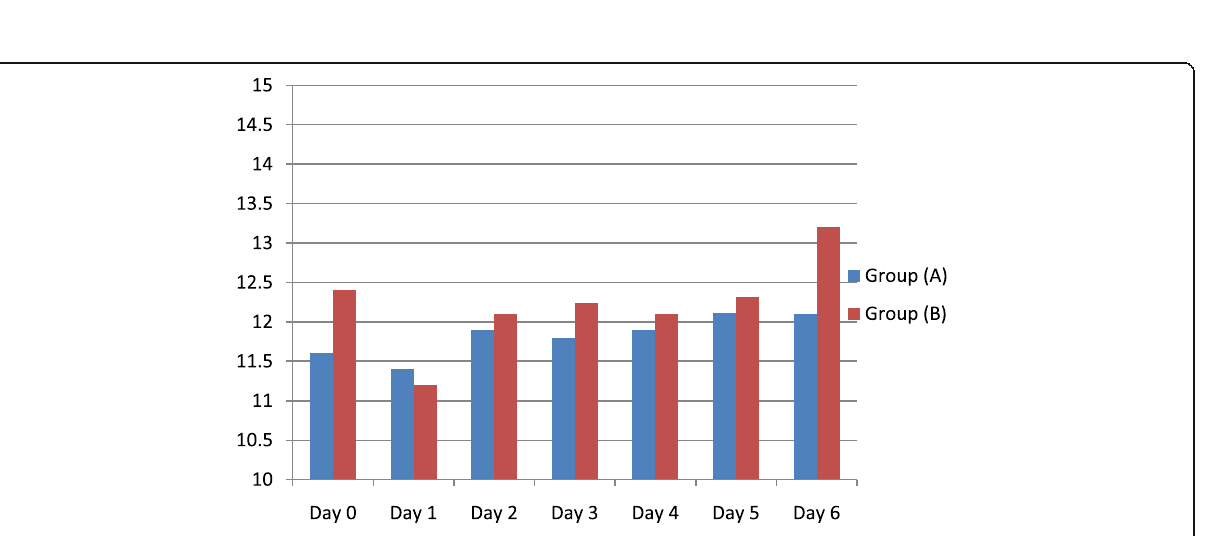
Fig. 2 Bar chart showing the comparison between group A (control) and group B (esmolol) according to heart